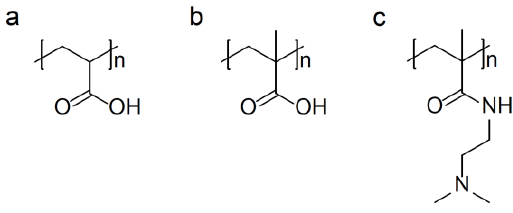
Figure 3. Chemical structures of common pH responsive polymers: ( a ) poly(acrylic acid); ( b ) poly(methyacrylic acid); and ( c ) poly( N , N -dimethyl aminoethyl methacrylamide).